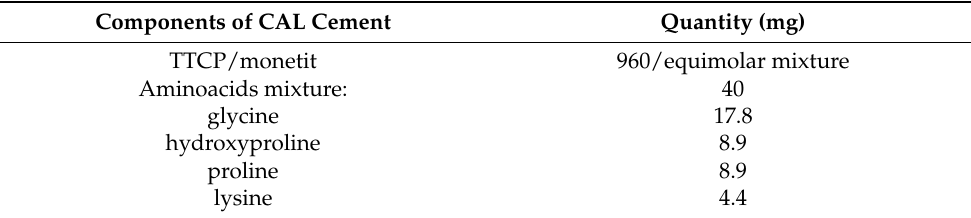
Table 1. Quantities of various components in 1000 mg of CAL cement